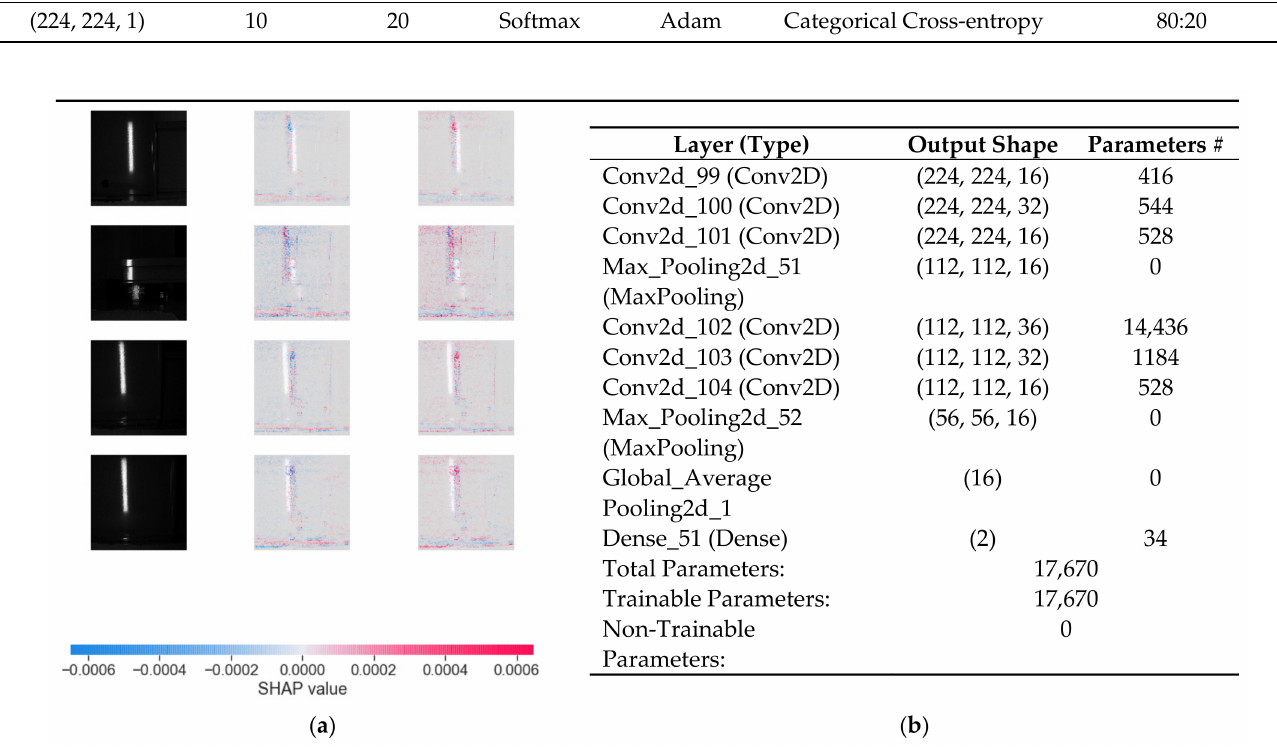
Figure 11. ( a ) SHAP Values and ( b ) LeNet + (1 × 1) Conv. + GAP Layers